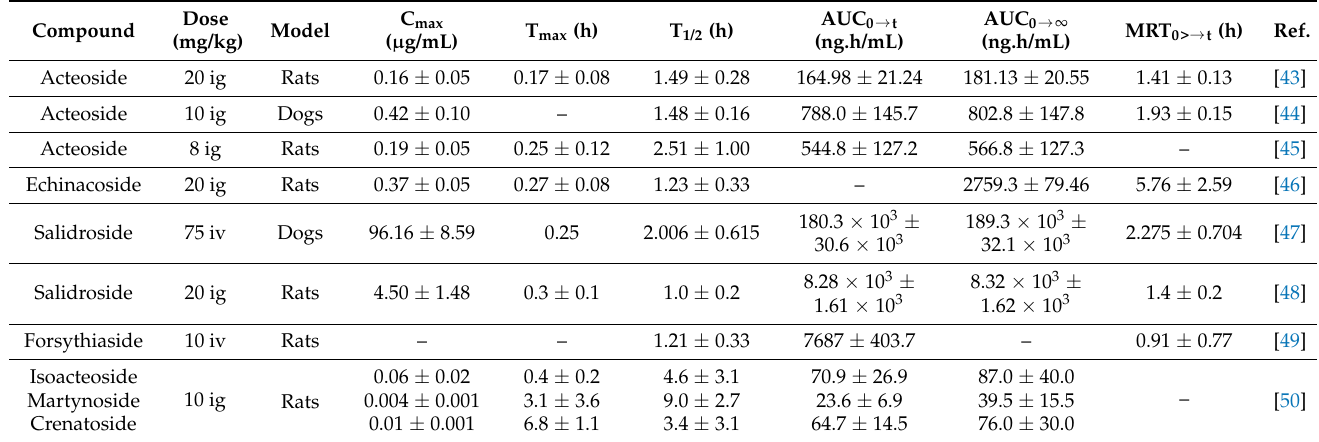
Table 2. The pharmacokinetic parameters of different